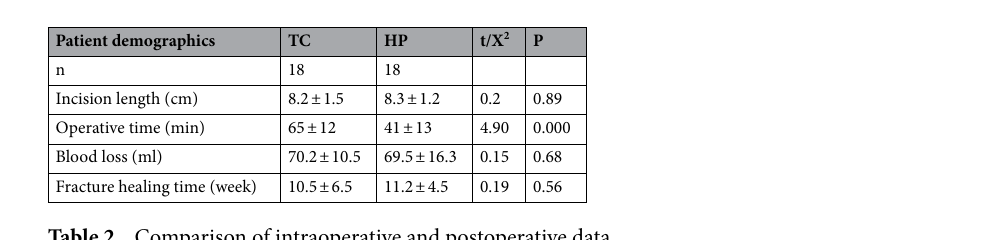
Table 2. Comparison of intraoperative and postoperative